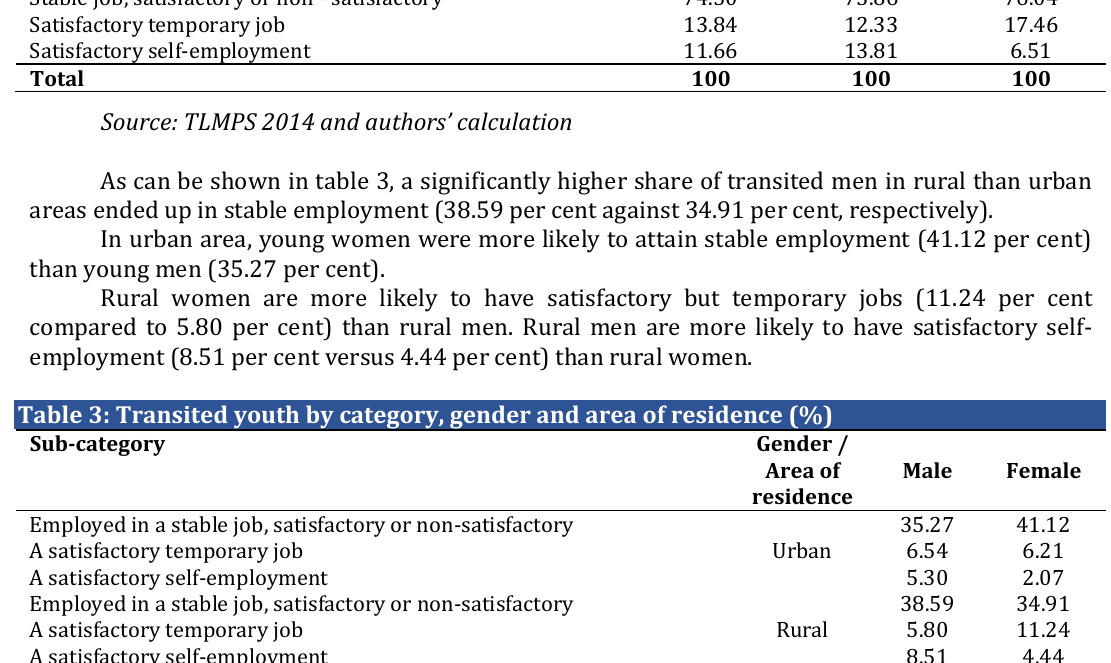
Table 2: Transited youth by category and gender (%) Sub-category